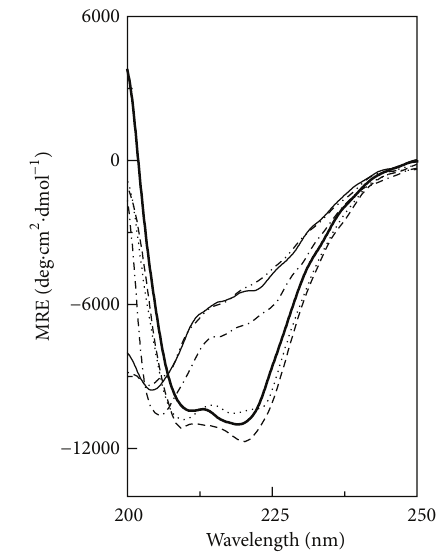
Figure 4: Normalized thermal transition curves of the native GA in the absence ( ◼ ) and the presence of 2.6M GLC ( 󳵳 ), 1.3M TRE ( I ), 8 M GLY ( ◊ ), and 8M EG ( 󳶃 ) as monitored by MRE 222 nm measurements, using a protein concentration of 1.4 𝜇 M.